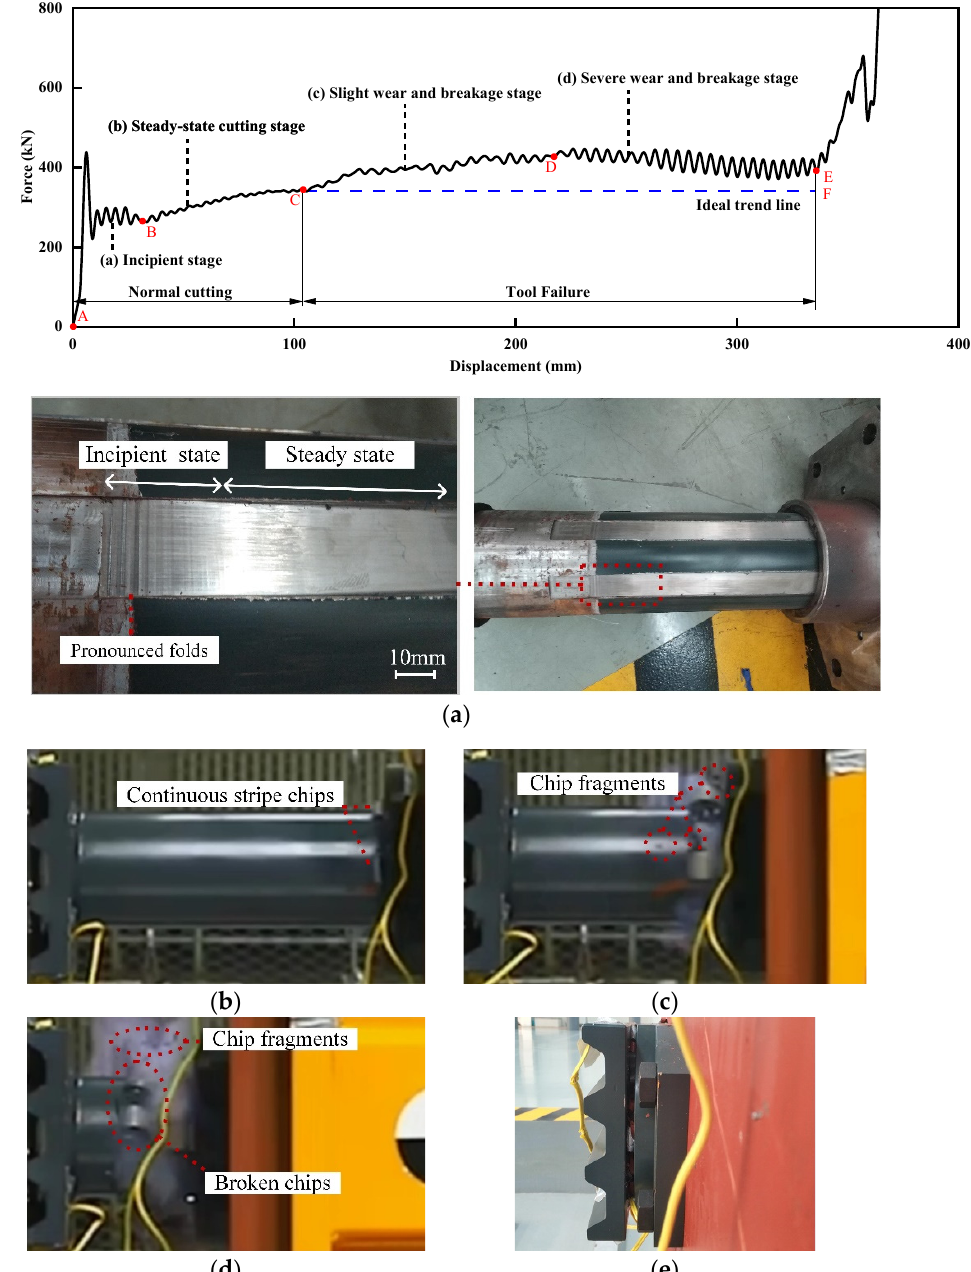
Figure 3. Force–displacement curves and structural deformation in various stages: ( a ) incipient stage, ( b ) steady-state cutting stage, ( c ) slight wear and breakage stage, ( d ) severe wear and breakage stage, and ( e ) after the collision.